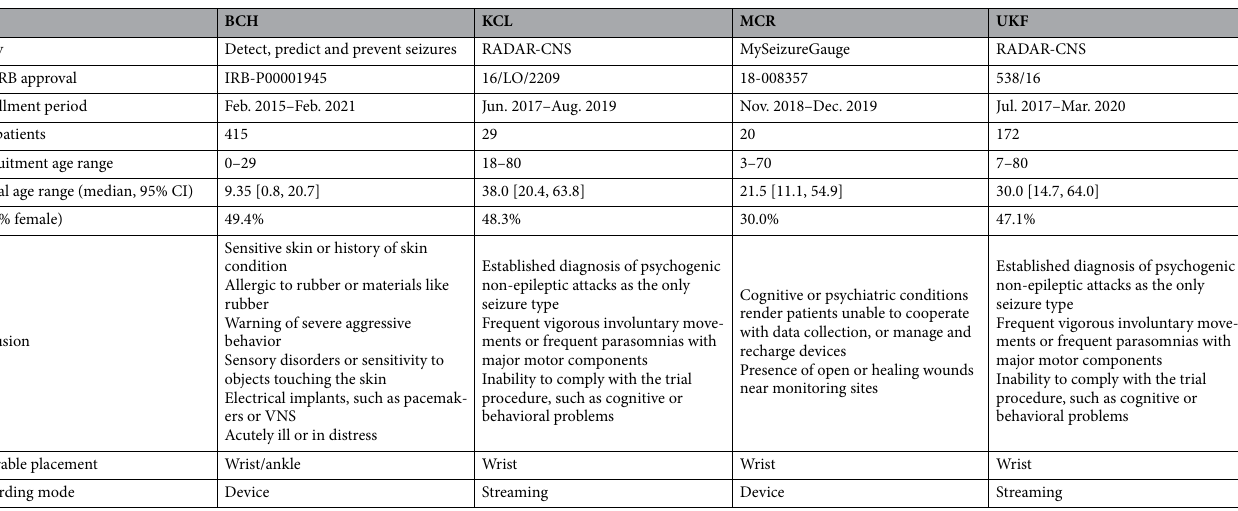
Table 1. Overview of inpatient EMU cohorts and recruitment. EC Ethics Committee, IRB Institutional Review Board, LTM long-time monitoring, EMU epilepsy monitoring